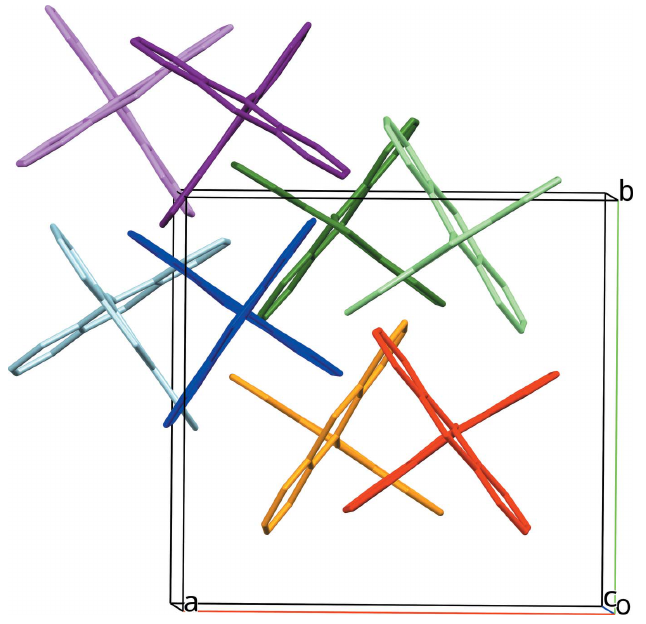
Figure 5 Crystal packing of (I). Molecules occupying similar positions in (I) and (II) are drawn with the same colour to illustrate the similarities between (I) and (II). distance of 3.8 A˚ between the thia-boraanthracene planes (Fig. 7). In (II), there are two C—H (cid:3) (cid:3) (cid:3) (cid:2) interactions with H (cid:3) (cid:3) (cid:3) Cg less than 3.0 A˚ [C4 A —H4 A (cid:3) (cid:3) (cid:3) Cg (C11 A –C16 A ) i : H (cid:3) (cid:3) (cid:3) Cg = 2.77 A˚ , C—H (cid:3) (cid:3) (cid:3) Cg = 147 (cid:2) ; C15 A —H15 A (cid:3) (cid:3) (cid:3) Cg (C31–C36) ii :